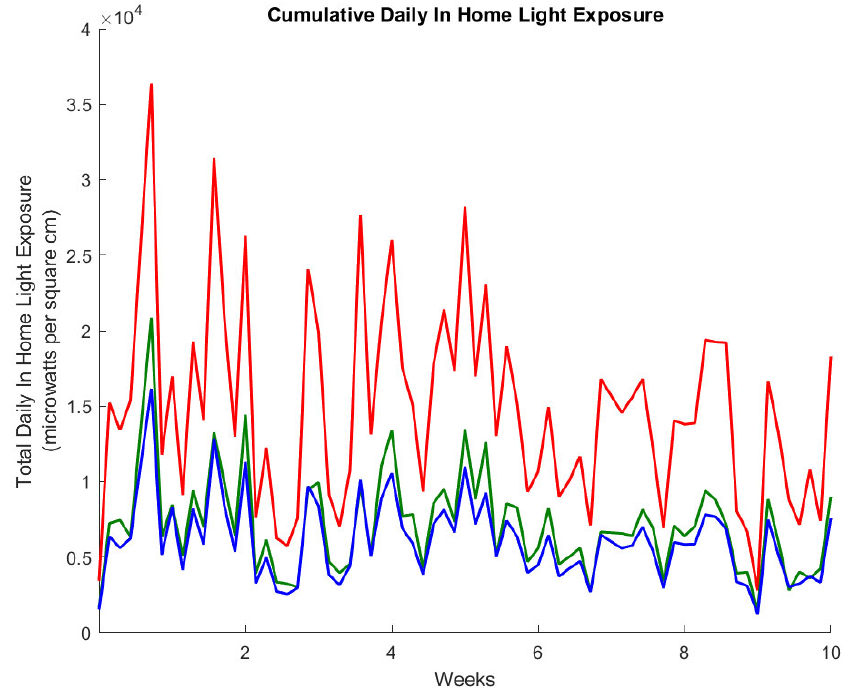
Figure 5. Cumulative daily in-home light received by a participant, factoring in specific room locations within the home: total daily in-home exposure (microwatts per centimeter squared) summed from the four rooms of the home of the study participant, using only light measurements from rooms when motion was detected within a five-minute period in that room. Color bands are defined as red